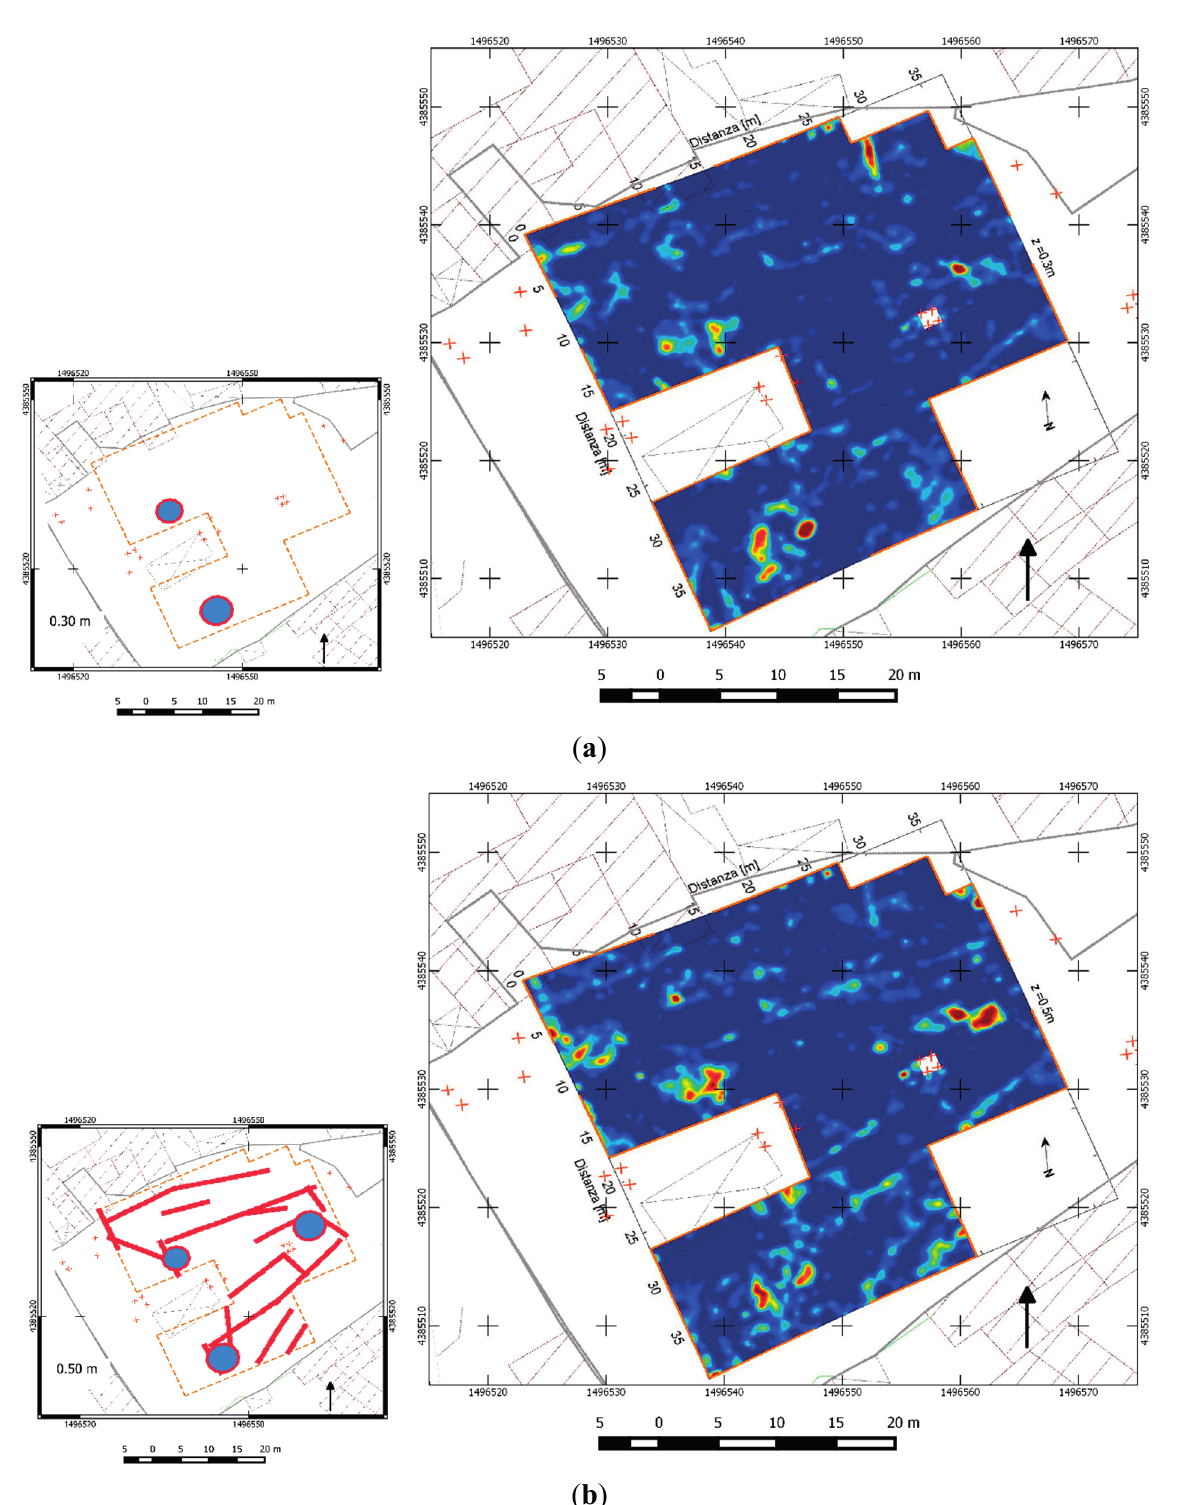
Figure 3. GPR maps and interpretation of the anomalies (on the left of every GPR map, an interpretative scheme is drawn reporting linear and concentrated anomalies) at